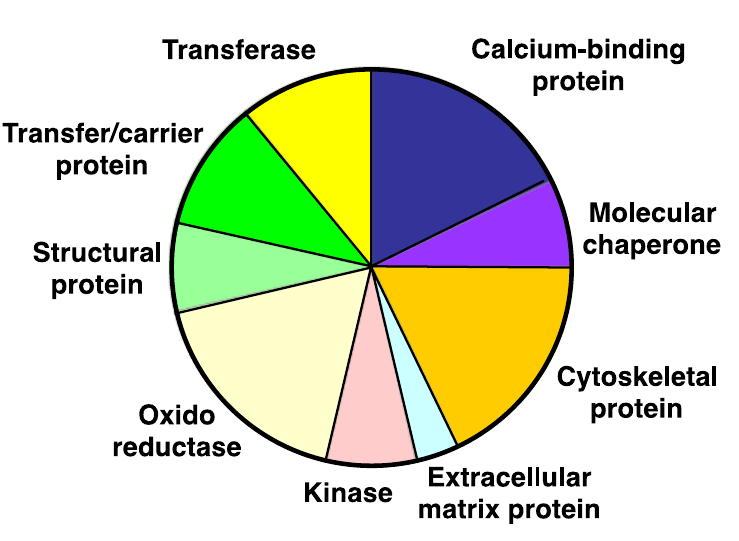
Figure 5. Molecular function of altered mdx diaphragm-associated proteins: